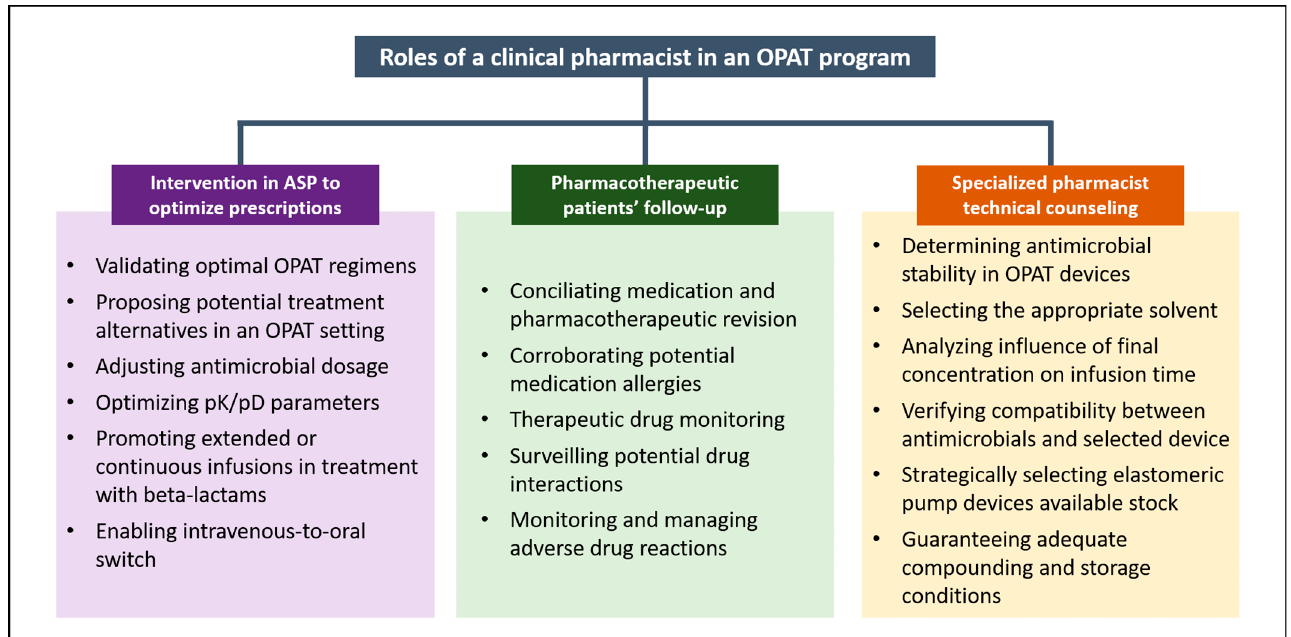
Figure 2. Main roles of clinical pharmacists in the OPAT multidisciplinary team presented in this review. The roles are divided into three main categories: intervention in ASP programs to optimize prescriptions, pharmacotherapeutic patient follow-up, and specialized pharmacist technical counseling.